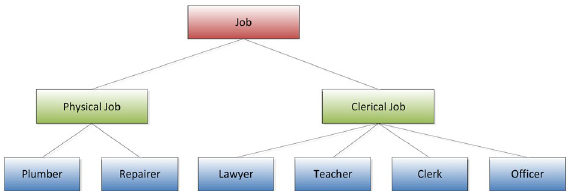
Figure 2. {Job} attribute generalization